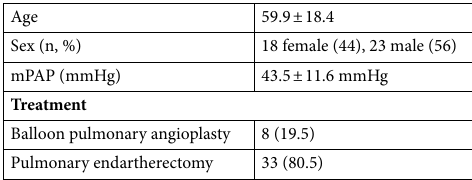
Table 1. Patient characteristics.